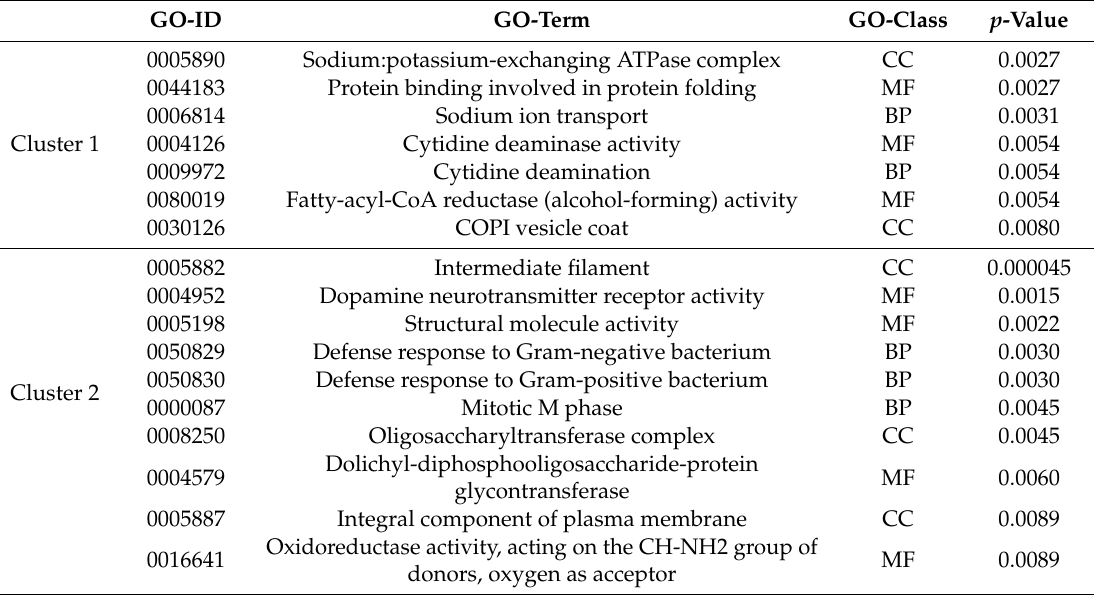
Table 1. Gene ontology (GO) terms of the 376 genes di ff erentially